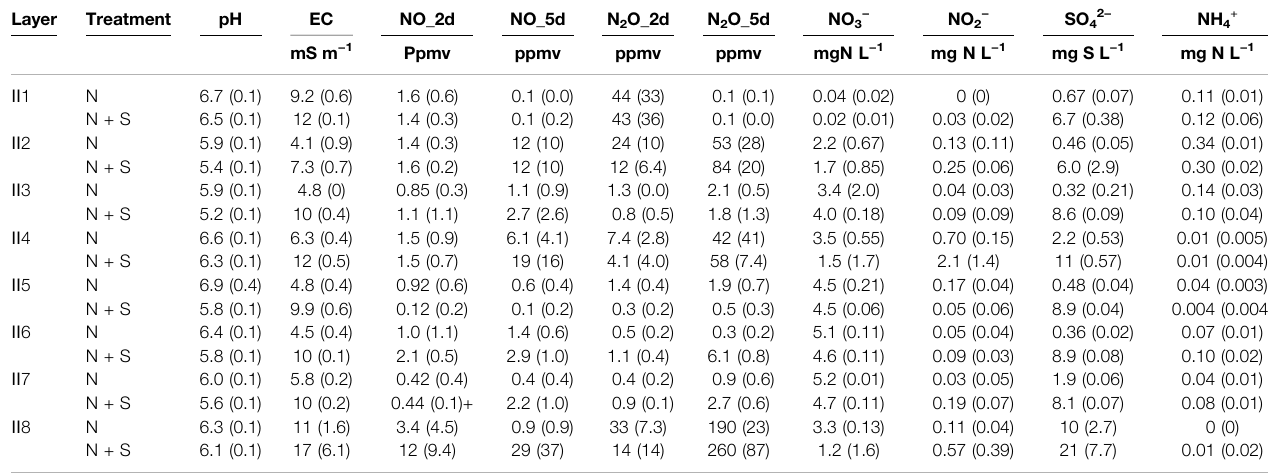
TABLE 3 | Summary data of the short-term incubation experiment using soils from streambank II. Values in parentheses indicate standard deviation ( n (cid:2) 3). Layer